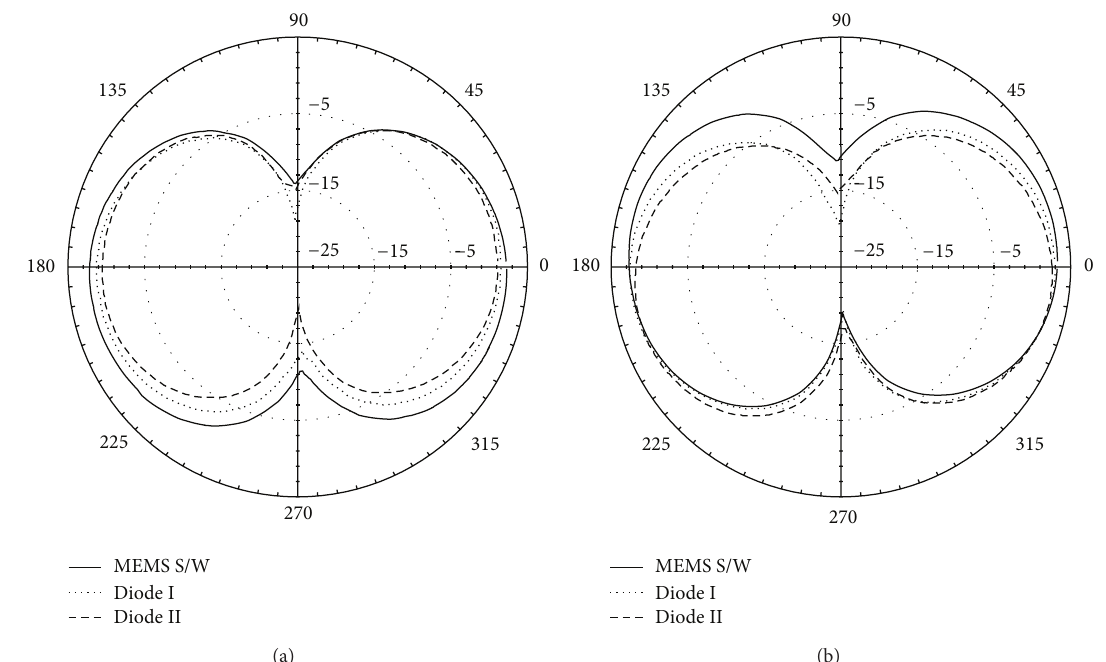
Figure 14: The radiation pattern of the proposed reconfigurable antennas ( xz -plane); (a) the monopole antenna and (b) the slot antenna.